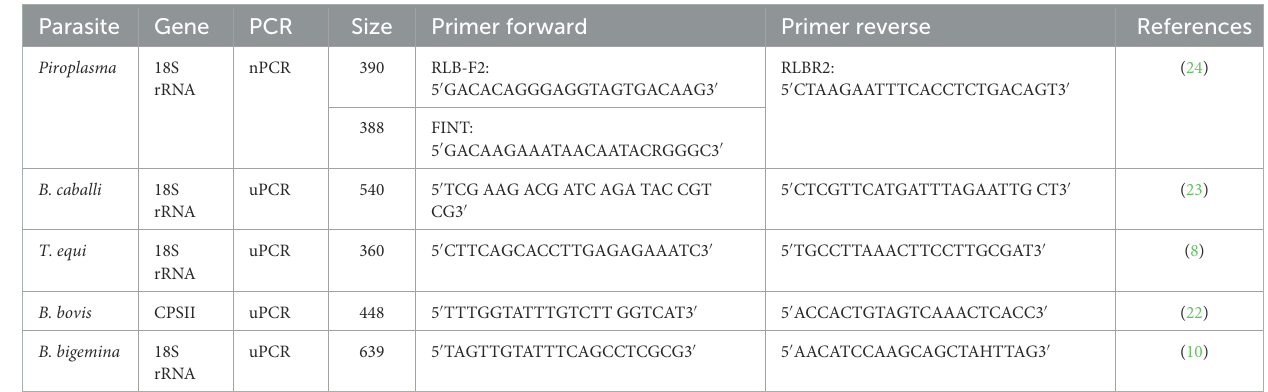
TABLE 2 Oligonucleotide primers used for DNA